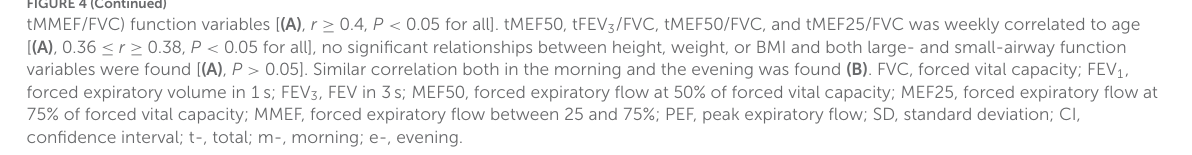
TABLE 3 Comparison of the CV of large- and small-airway function variables according to age.